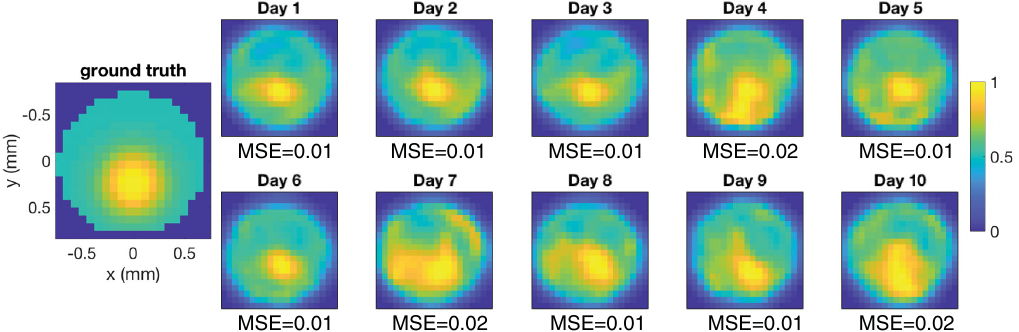
FIG. 7. Simulated ground truth (at left) and day-by-day reconstruction using recorded LCLS VCC images and simulated bucket measurements. The reconstructions are not data-limited, so the changes day-to-day are systematic errors due to the varying distribution of laser profiles. Also, note that a faint circular ring of high QE appears consistently on the aperture of the laser profile. This is in error with the simulated ground truth, implying that it is an artifact of the reconstruction algorithm.